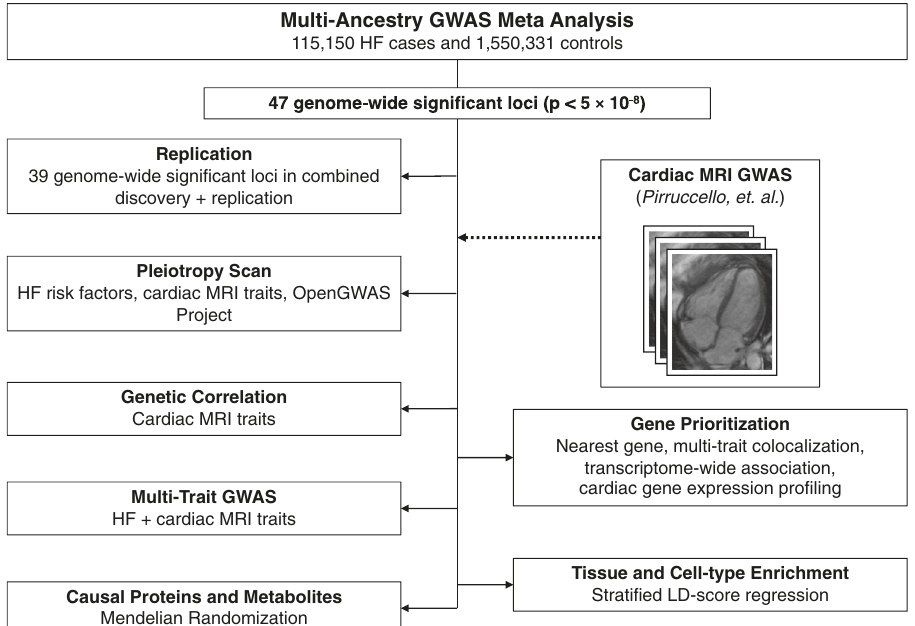
Fig.1|Studyoverview. OverviewofmajorstudyanalysestoidentifyHF-associatedgeneticvariants,sharedrisklociwithothertraits/diseases,prioritizegenes/tissues/cell types, and identify potential treatment targets. GWAS genome-wide association study, HF heart failure, LD linkage